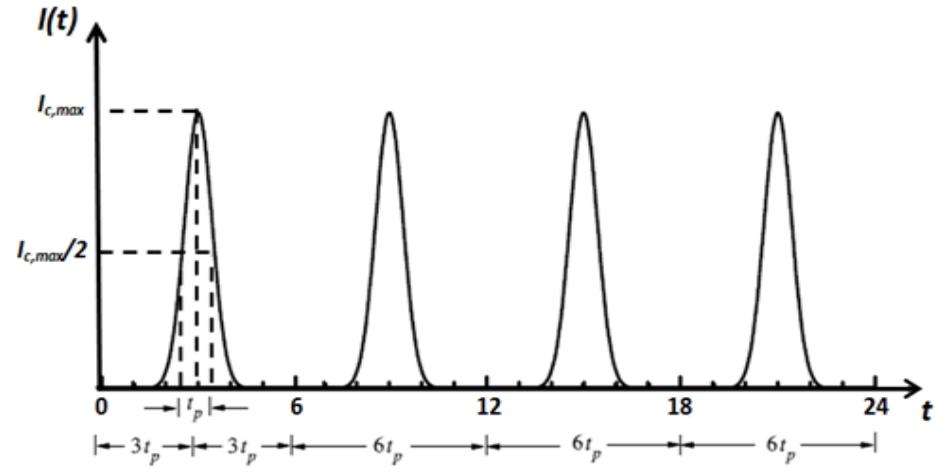
Figure 3. Temporal profile of the incident short-pulse (ultrafast) laser.